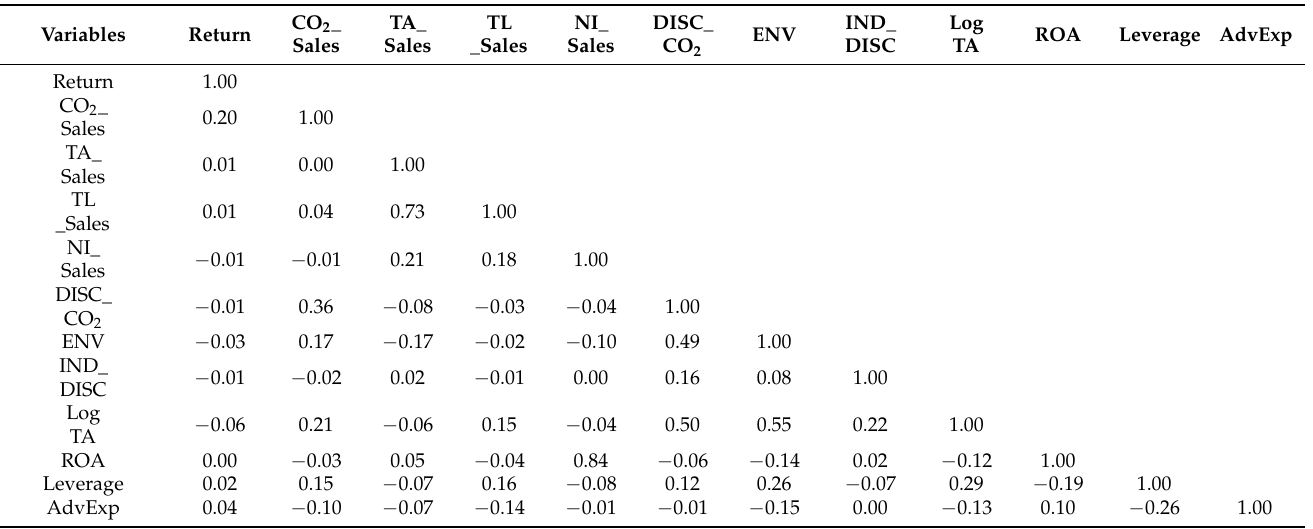
Table 5. Correlation coefficients.